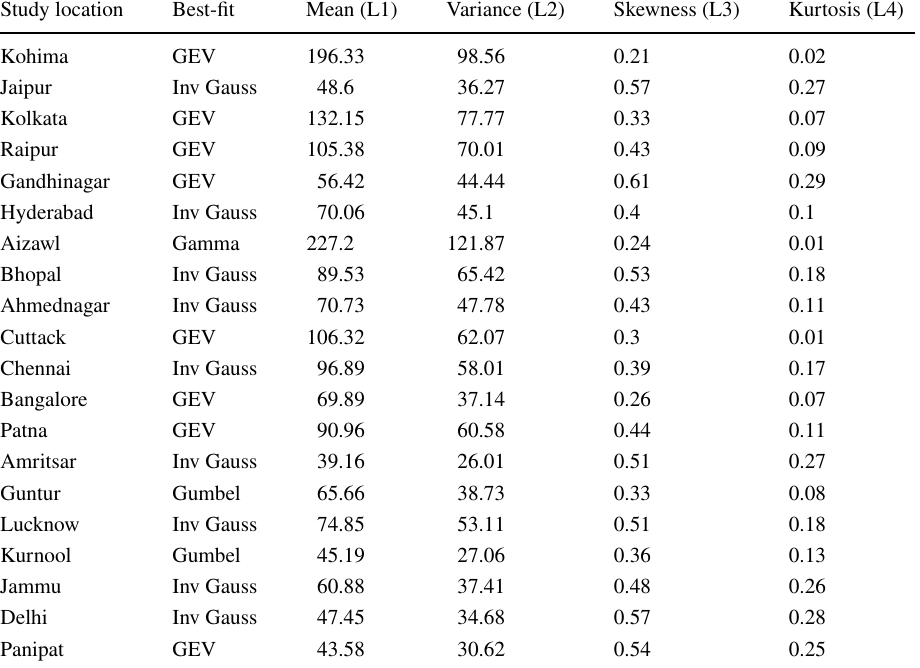
Table 5 Parameters estimates using sample L-moments [mean (L1), variance (L2),